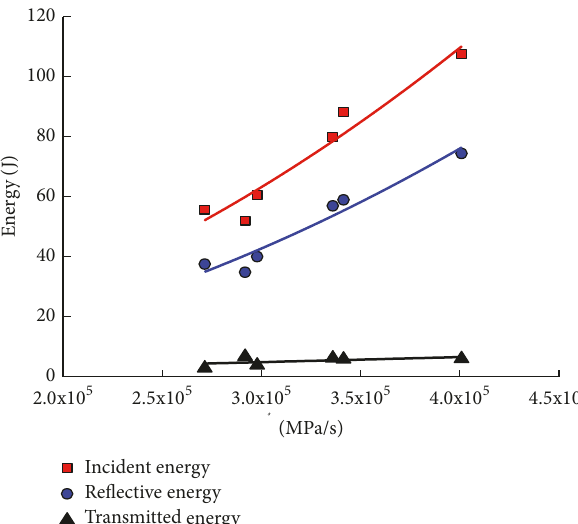
Figure 10: The relationship between the first peak stress and loading rate.